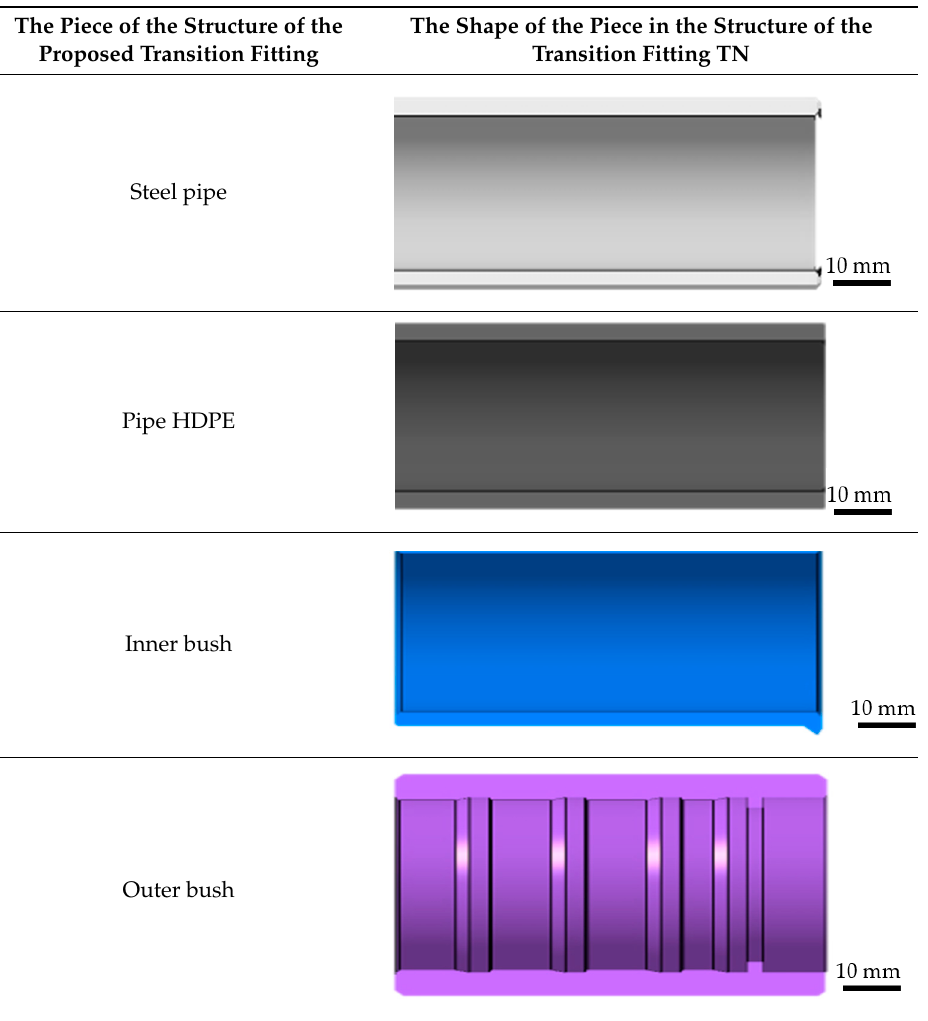
Table 14. Transition fitting structure TN.